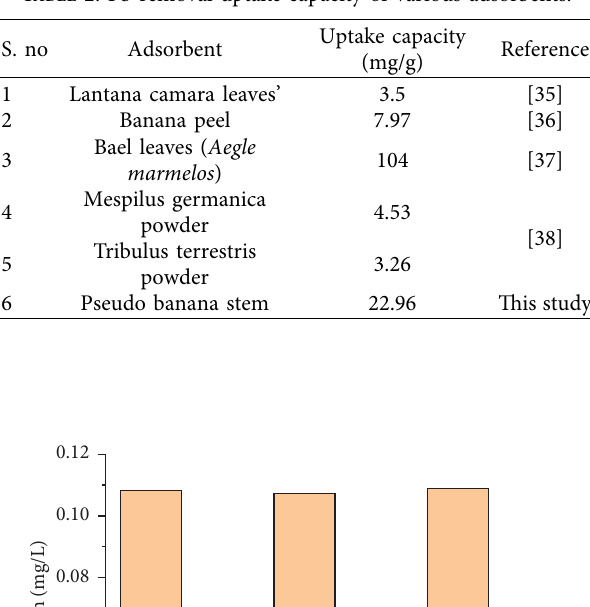
Table 2: Pb removal uptake capacity of various adsorbents.